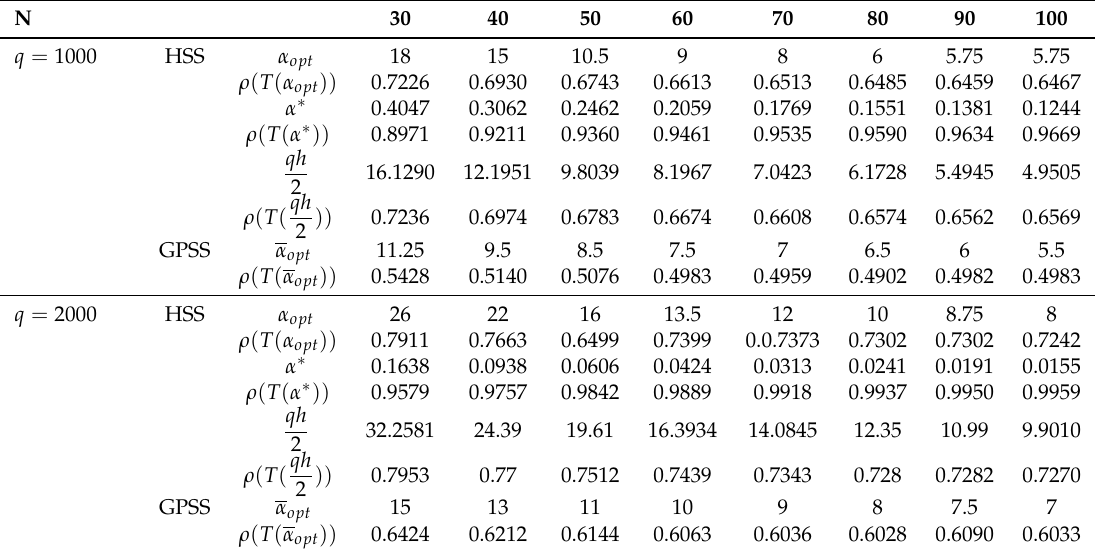
Table 3. Optimal value of α for HSS and GPSS inner iterations for different values of N and q of Example